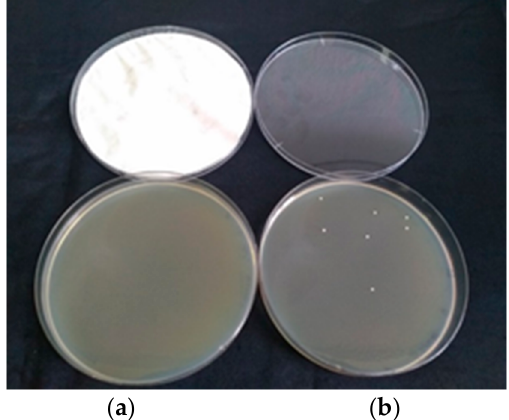
Figure 11. Example of antimicrobial testing results for S. cerevisiae after 48 h of incubation: ( a ) 30 g/m 2 paper coating of in situ microcapsules with citronella oil, activated by 5 kg weight in 140 mm Petri dish; ( b ) blank sample without coated paper.